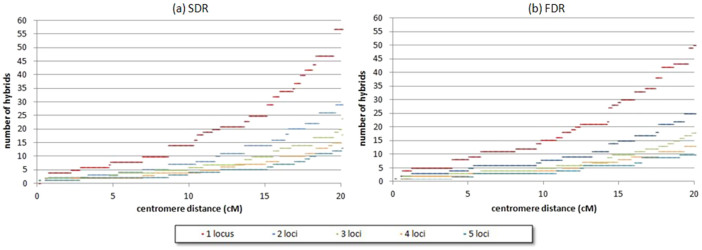
Number of hybrids needed to obtain significant conclusions for (a) SDR and (b) FDR mechanisms.